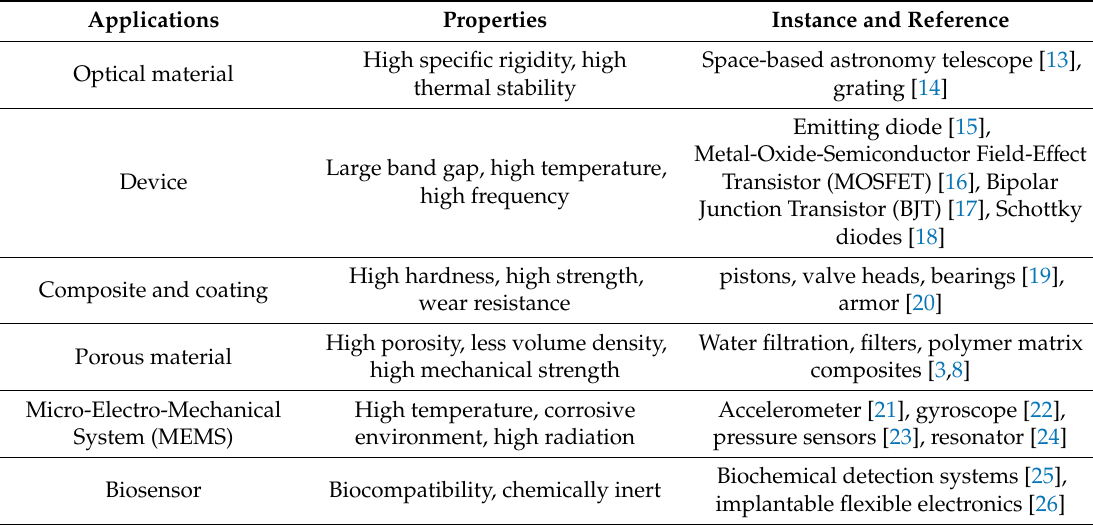
Table 1. The applications and corresponding properties of silicon carbide